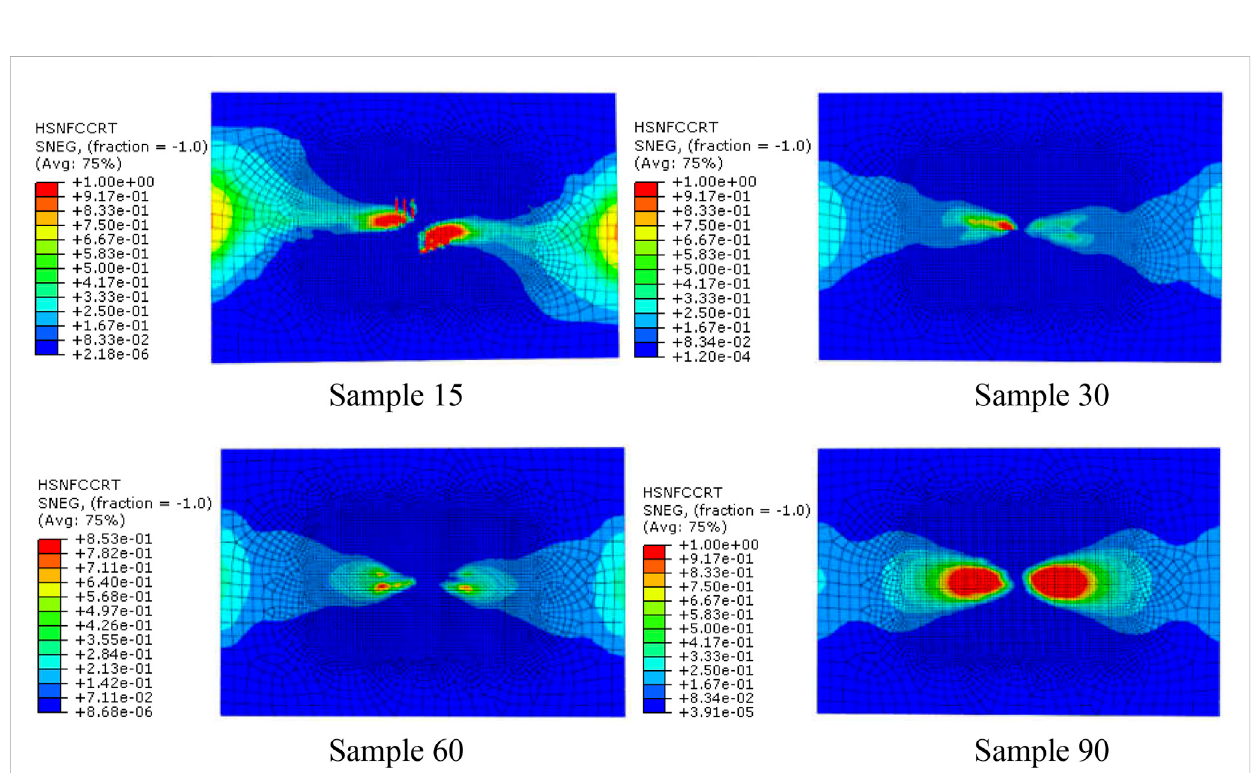
FIGURE 8 The fi ber compression failure distribution when the impact energy is 20 J (the red area represents the part of fi ber compression failure).